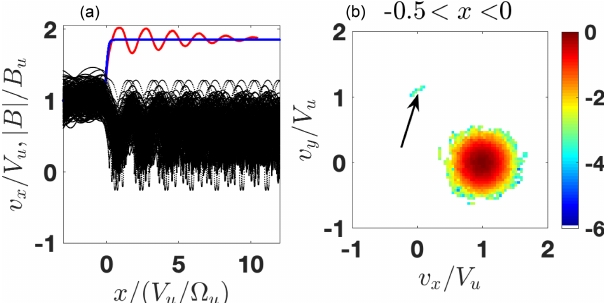
Figure 5. (a) The modeled (blue) and the predicted (red) magnetic profiles as well as the ion orbits x vs. v x . (b) A slice of the ion distribution inside the ramp. The shock parameters are M = 2 . 1, θ = 65 ◦ , R = 1 . 85, β i = 0 . 2, β e = 0 . 35, and s = 0 . 65. The arrow points to the (quasi-)reflected population.